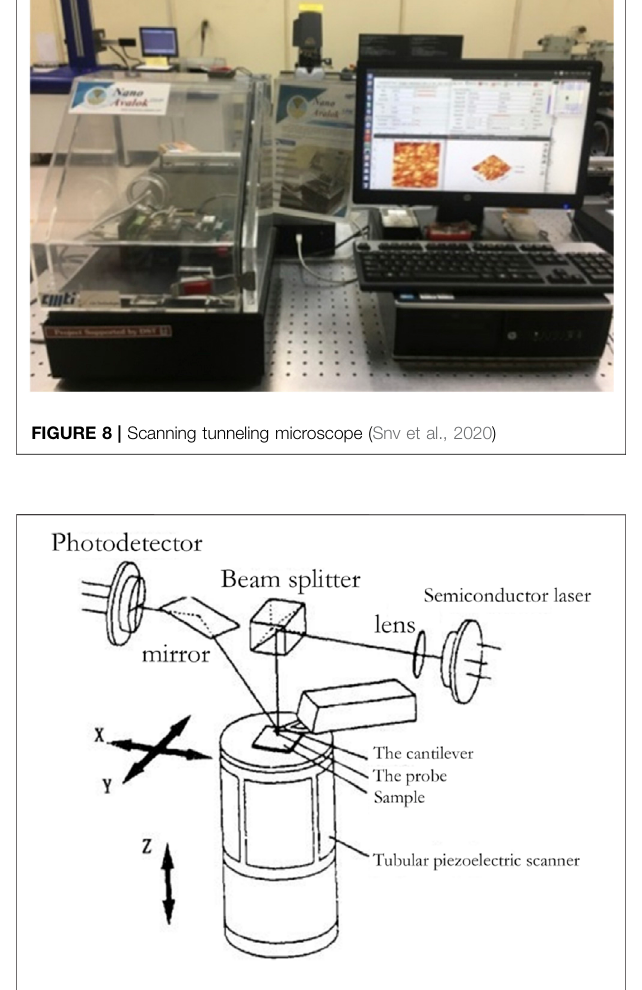
FIGURE 9 | Schematic diagram of atomic force microscopy (Zhang,